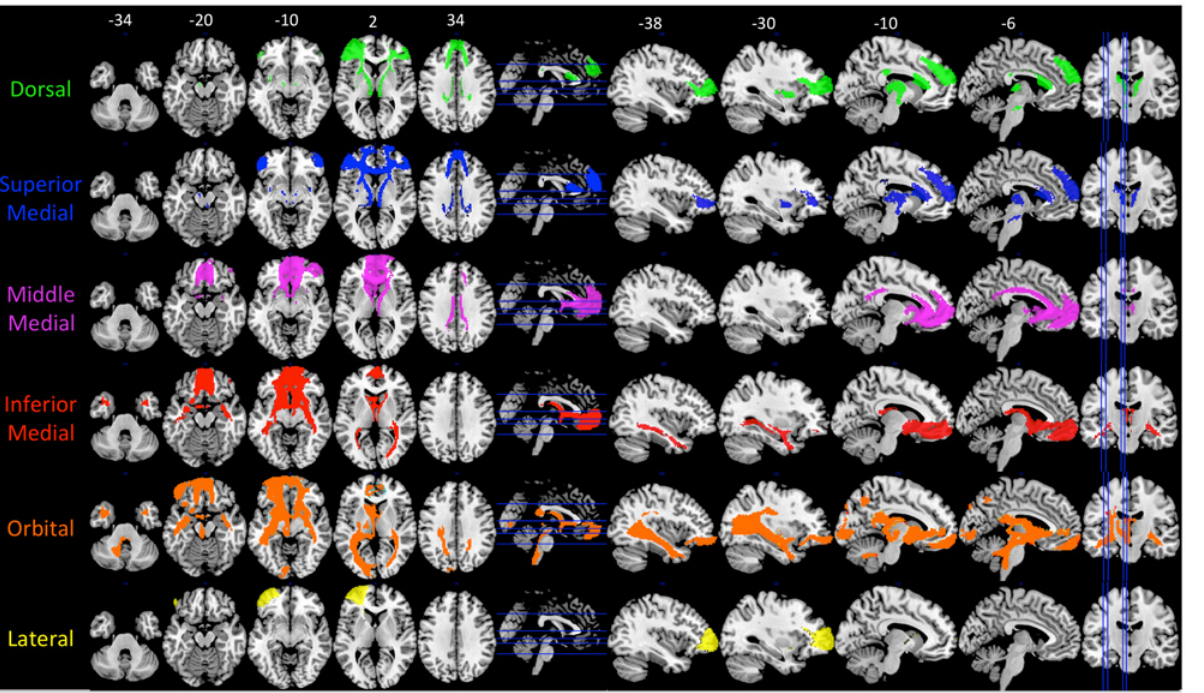
Fig 6. Tracts that had significantly greater connectivity strength to a designated cluster compared to the average of all other cluster tracts for the left hemisphere K = 6 solution. Comparisons were cluster-level FWE-corrected to p < .01. The color of the tract and the label corresponds to the color of the cluster in Fig 2. Axial slices are shown in the left column, with slice locations marked on the sagittal slice with a blue line. Sagittal slices are shown in the right column, with slice locations marked on the axial slice with a blue line. MNI coordinates for the z -axis (axial slices) and x -axis (sagittal slices) are shown above the top row.